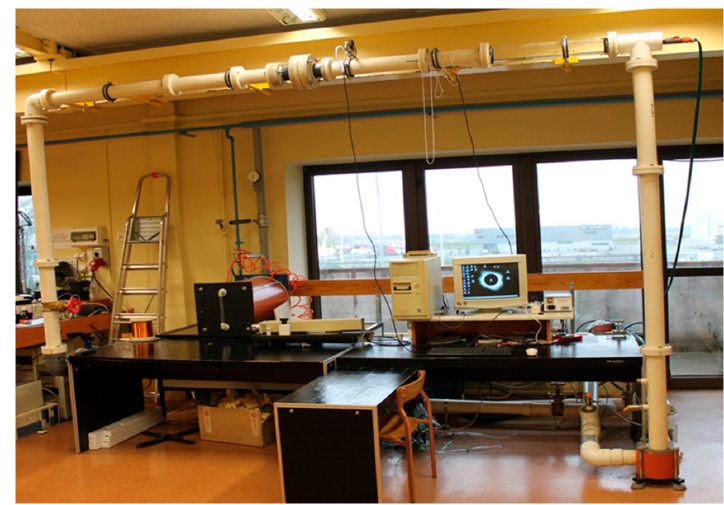
Figure 1. View of experimental setup.